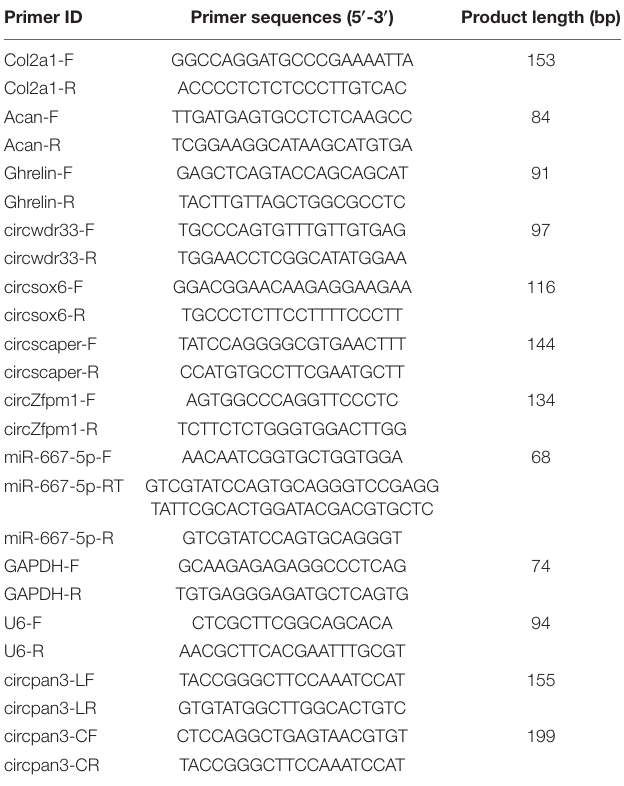
TABLE 1 | Primers applied for RT-qPCR method. Primer